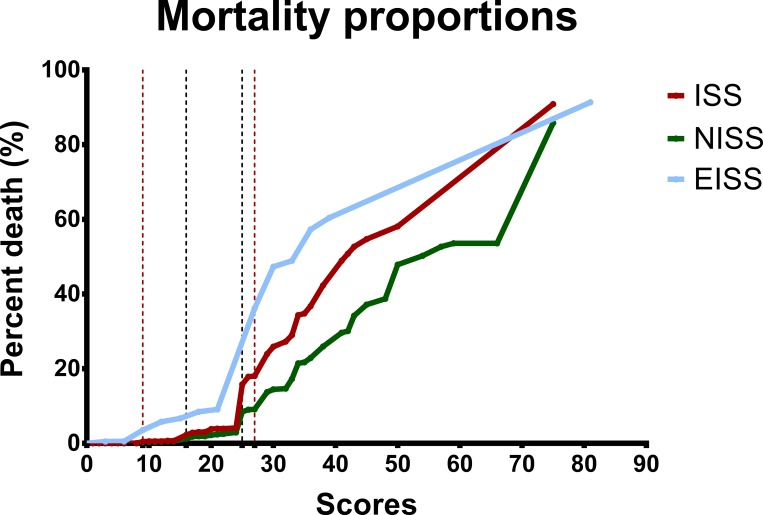
The mortality rate-to-severity score relationships of all patients classified according to the ISS, NISS, and EISS.